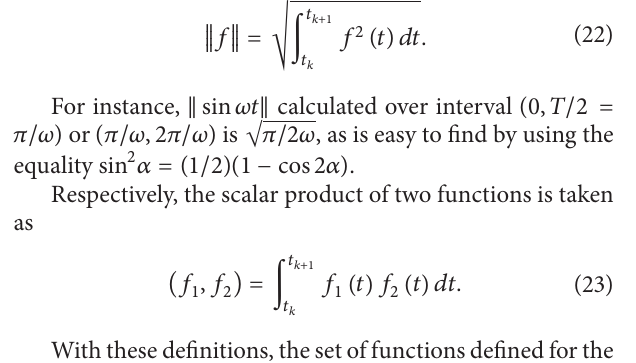
Figure 18: Because of the mutual compensation of two half-waves of ℎ(𝜆) , only each third half-wave of ℎ(𝑡) contributes to the extreme value (𝑡) , and the maximum overlaps between ℎ(𝜆) and 𝑓 of 𝑓 out needed!) to similarly consider the cases of 𝑇 = 5𝑇 𝑜 and so